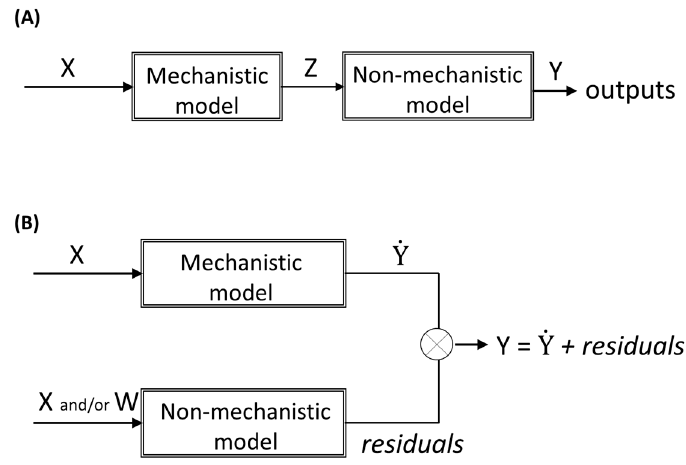
Figure 3. Hybrid modelling structures: ( A ) serial; ( B ) parallel.